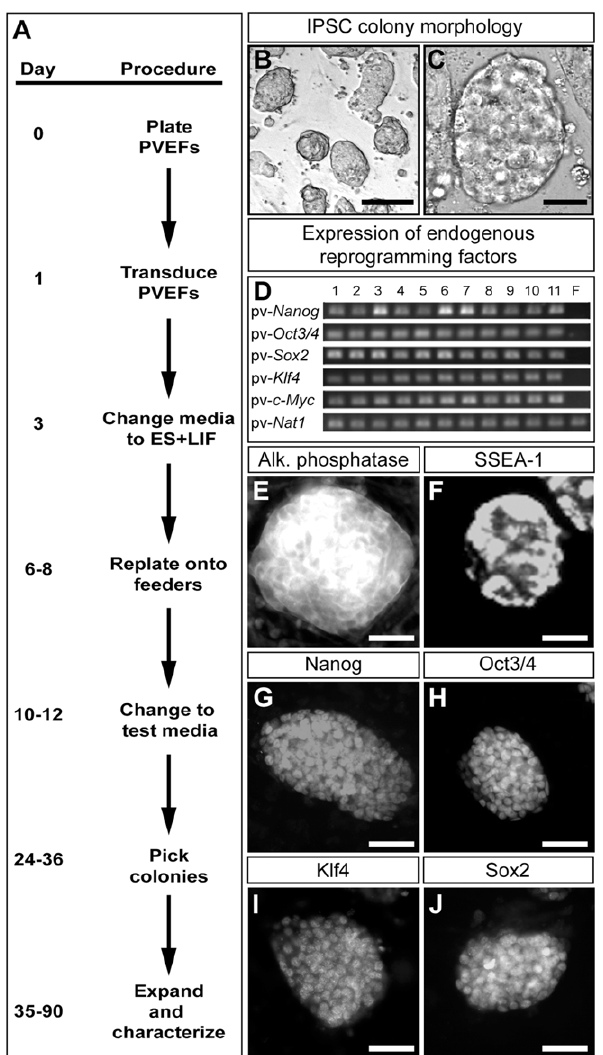
Figure 1. Induction and characterization of PVi lines. ( A ) Protocol for reprogramming PVEFs. All brightfield and immunolabeling images (B, C, E–J) depict colonies of a single representative PVi line (line 6). ( B– C ) Colony morphology of a PVi line. Colonies display morphology similar to that of mouse ES cells, including distinct raised colonies (B), with tightly-packed cells and well-defined, phase-bright margins (C). ( D ) RT-PCR for endogenous reprogramming factors in PVi lines. RT-PCR for pv- Nat1 was performed as a positive control for an endogenous, ubiquitously expressed gene that should be expressed in all cells irrespective of their reprogramming state. Lanes 1–11 show PCR products from PVi lines 1–11, respectively. Lane 12 (‘‘F’’) shows PCR products from PVEFs. ( E ) PVi colony exhibiting alkaline phosphatase (Alk. phosphatase) activity. ( F ) Live immunofluorescent labeling of a PVi colony for SSEA-1. ( G–J ) Immunofluorescent labeling of PVi colonies for Nanog, Oct3/4, Klf4, and Sox2. Scale bars equal 500 m m ( B ), 100 m m ( C, E ), and 50 m m ( F–J